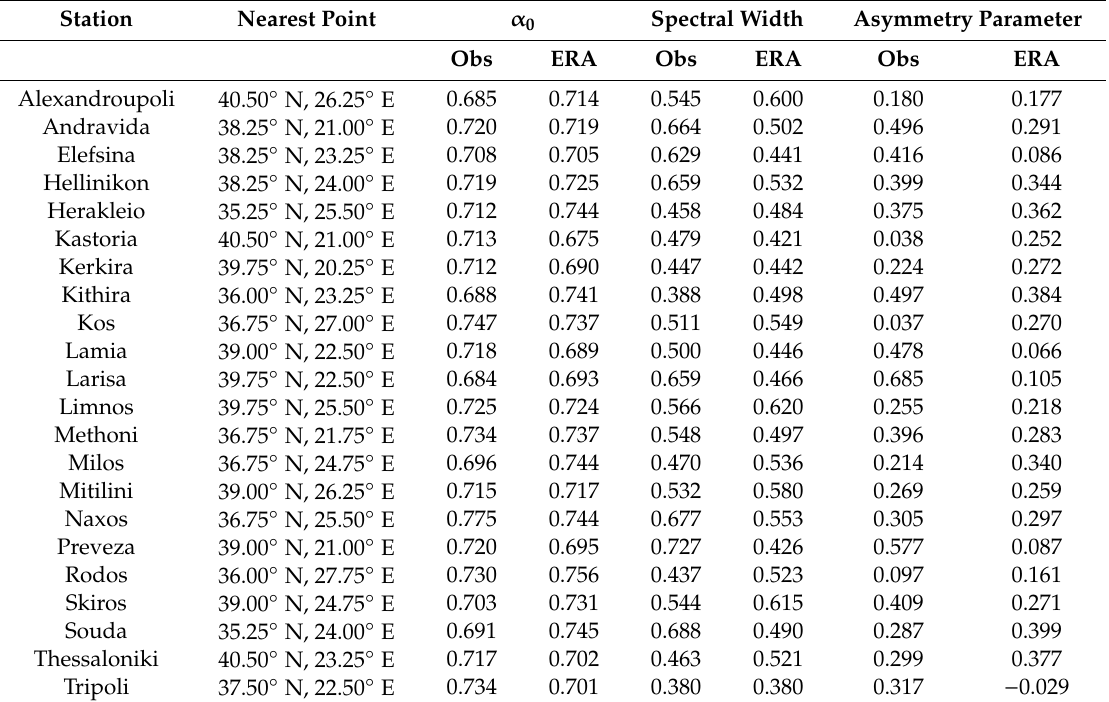
Table 1. Spectral parameters’ values of observational (Obs) and ERA-Interim (ERA) time series for the closest to the station grid points.